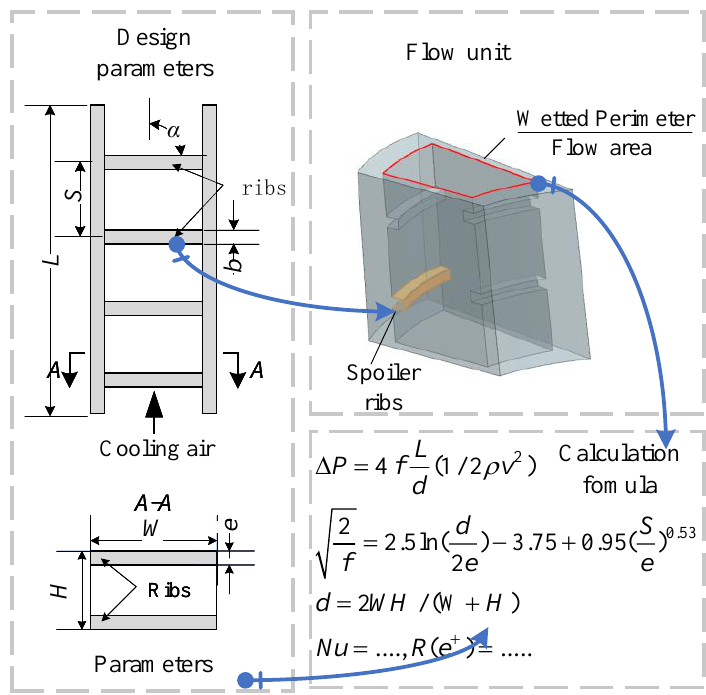
Figure 26. U 15 unit physical model and geometric structure [34]. Table 2. Some important data of U 15 unit for pipe-network calculation.